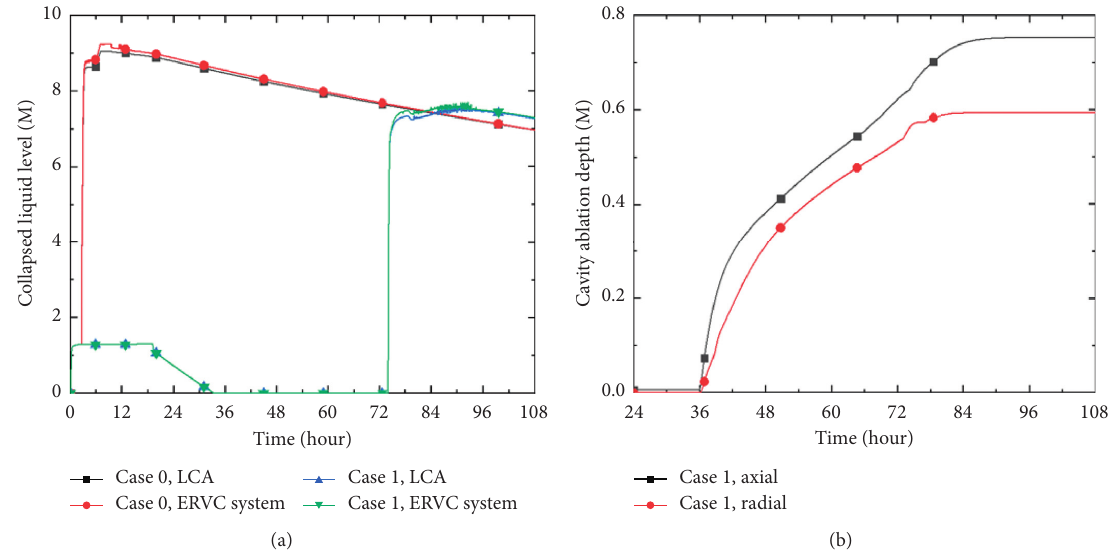
Figure 5: (a) Collapsed liquid level (0m � bottom of the cavity) in the lower containment area and ex-reactor vessel cooling system; (b) ablation depths of the